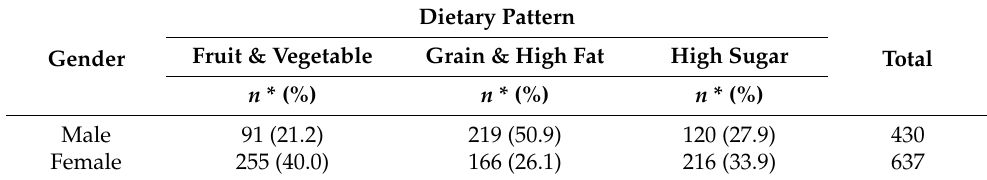
Table 4. Gender distribution of three dietary patterns.